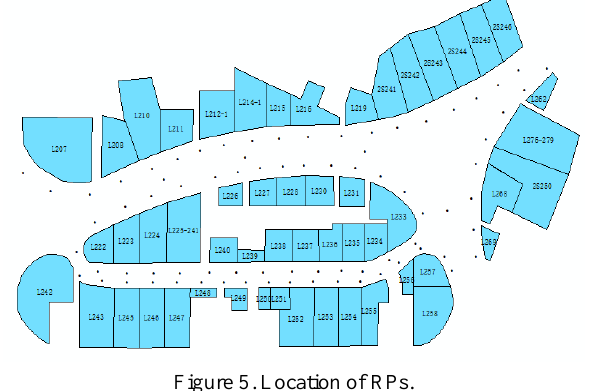
Figure 5. Location of RPs.